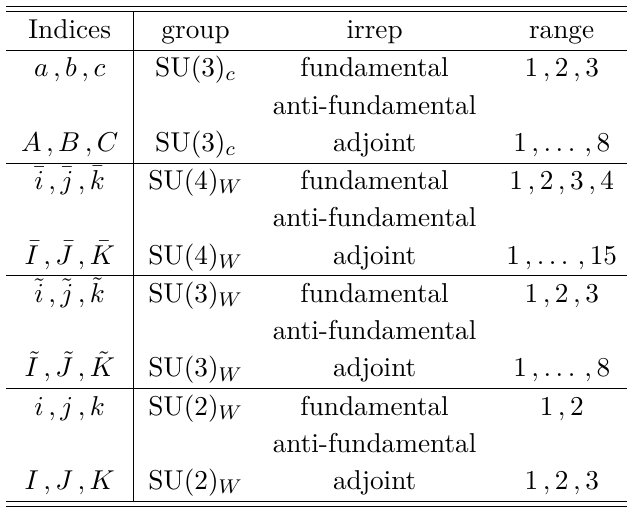
Table 13 . Definition of indices for various gauge